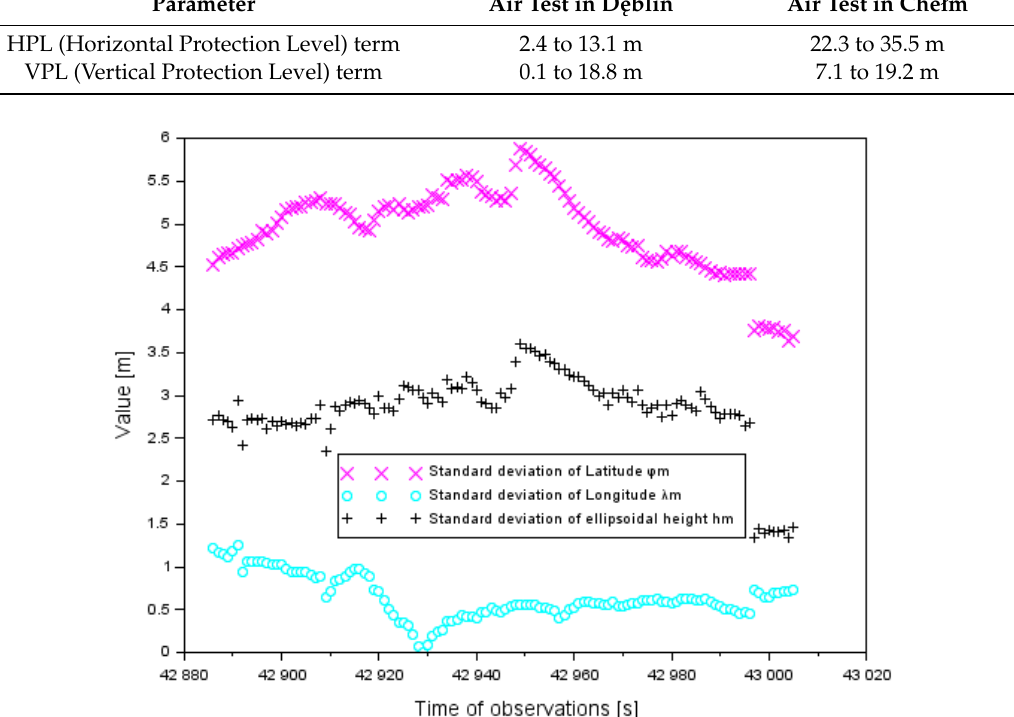
Table 5. Comparison of the standard deviation of an average aircraft position in the flight tests in D ę blin and Che ł m.